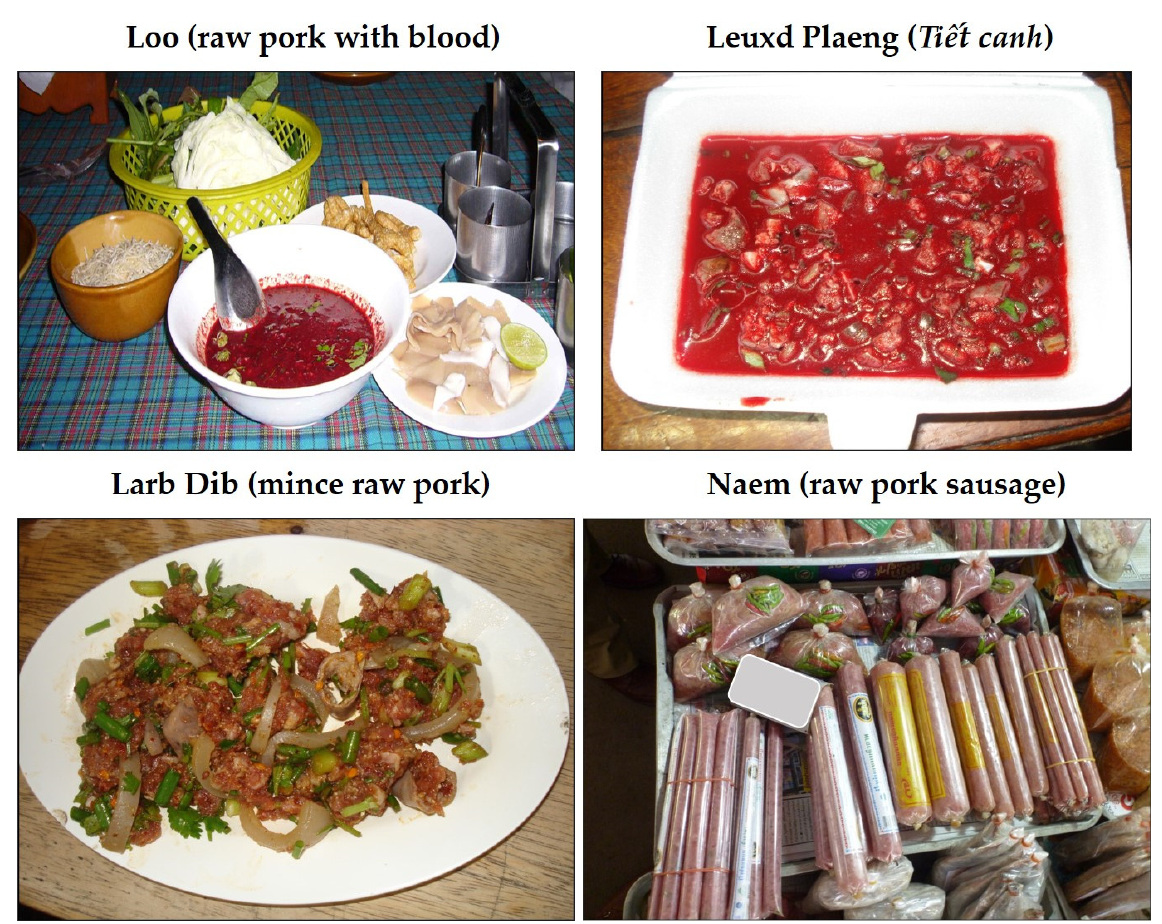
Figure 1. High-risk dishes available in Thailand.